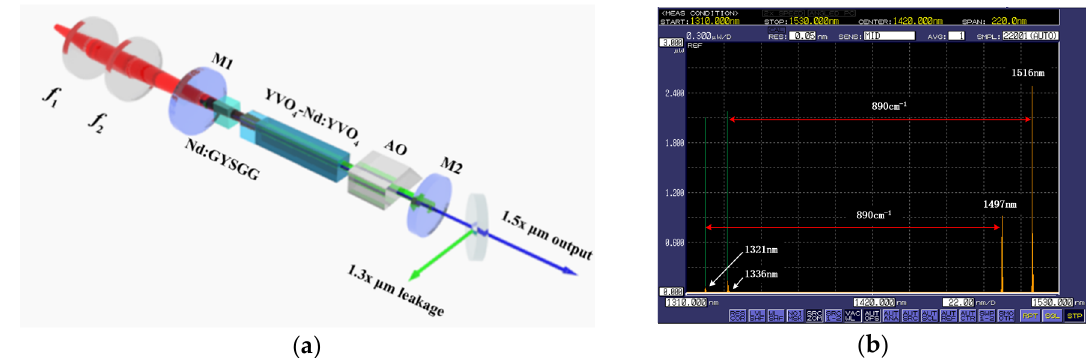
Figure 12. Schematic of the dual-wavelength YVO 4 Raman laser intracavity pumped by an Nd:GYSGG laser ( a ) and the output fundamental/Stokes spectrum ( b ) [58].